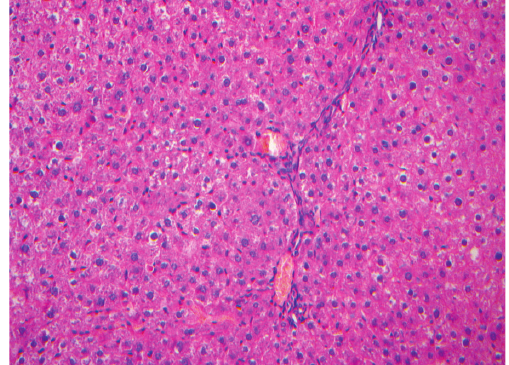
Figure 3: The pathological stage of the 5th–8th week is S2. The figure was the general appearance of liver pathology: there were evi- dent swellings of the liver. Under the microscope, the hepatic lobu- lar architecture was unclear, the arrangement of hepatic plate was disorganized, the hepatocytes showed vacuolar degeneration, and the hepatocytes showed necrosis in fragments. The liver sinusoid was narrowing or disappeared by compression. The fibrosis could be observed in the portal area but was localized in the lobule. HE. Bar 5200mm.